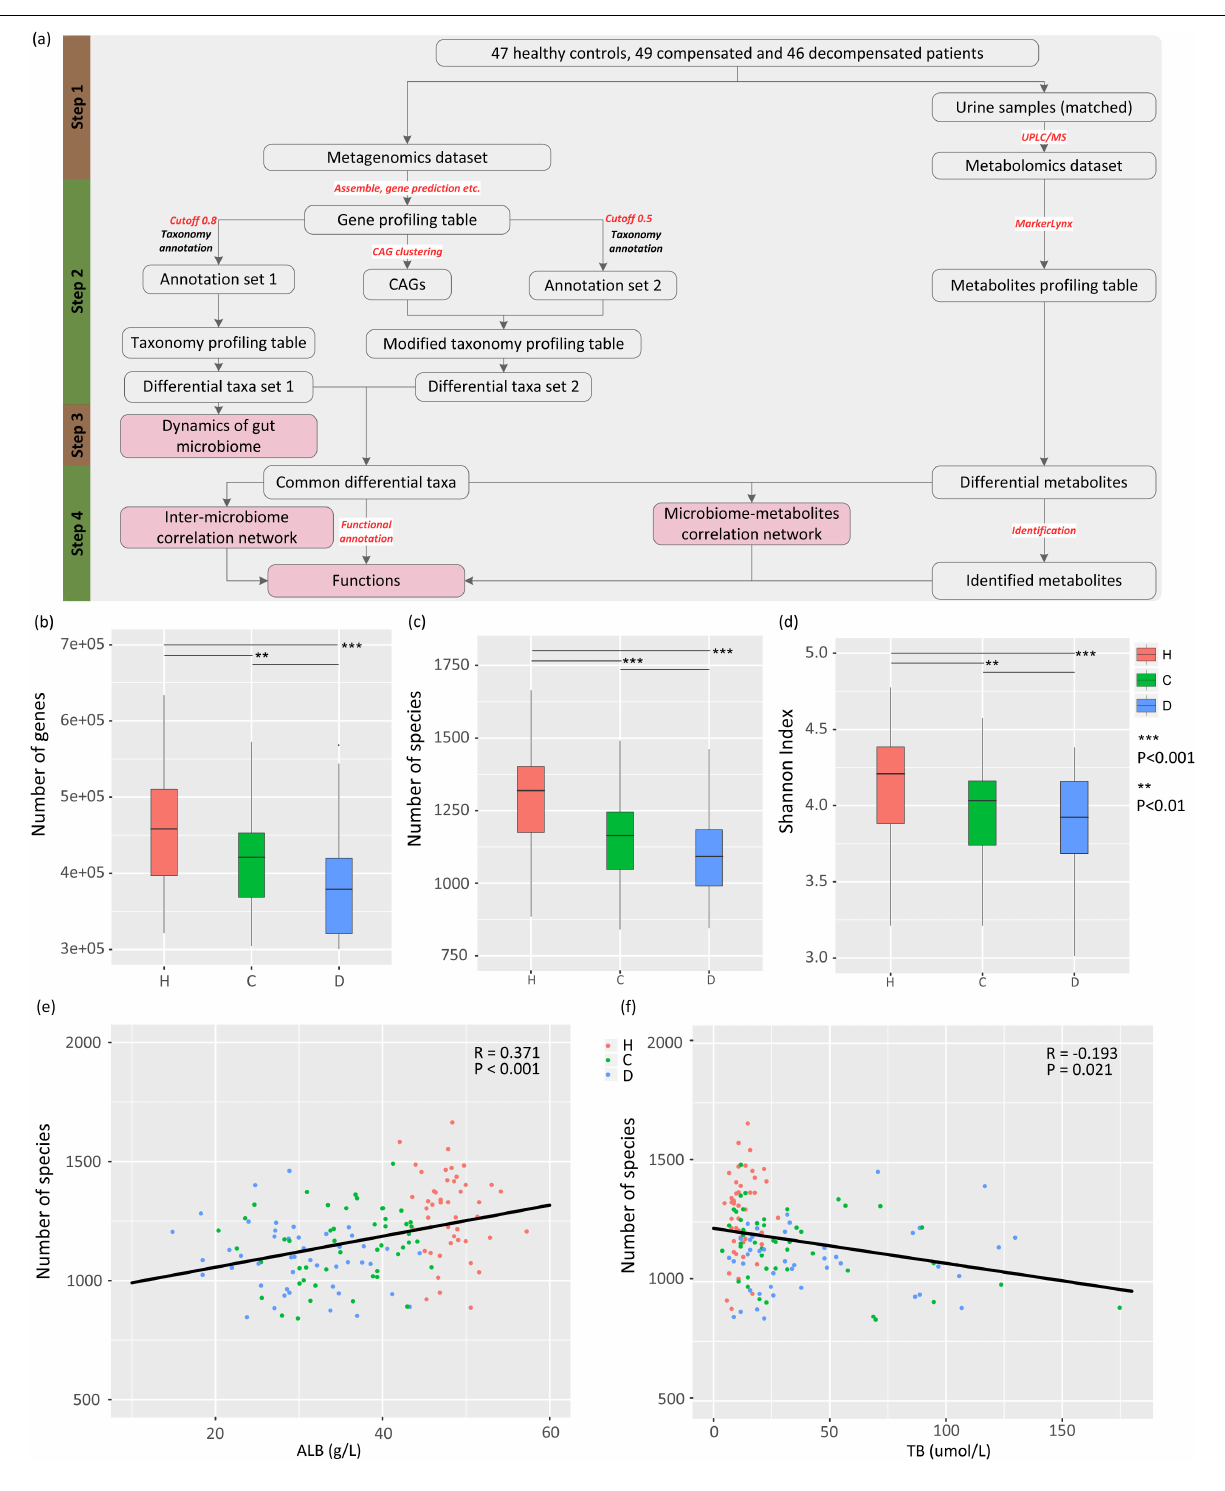
Frontiers in Microbiology |